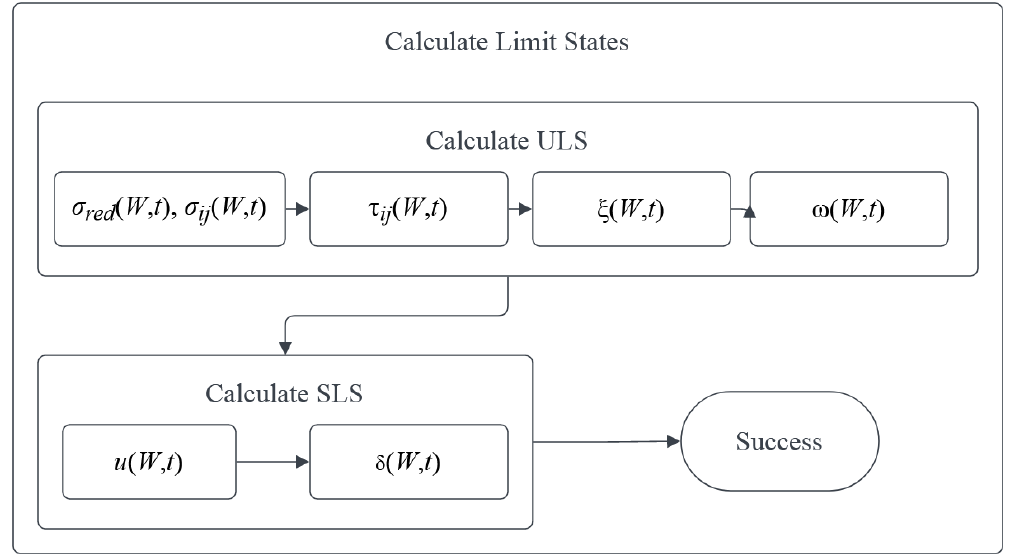
Figure 2. Procedure for the determination of the limit states.